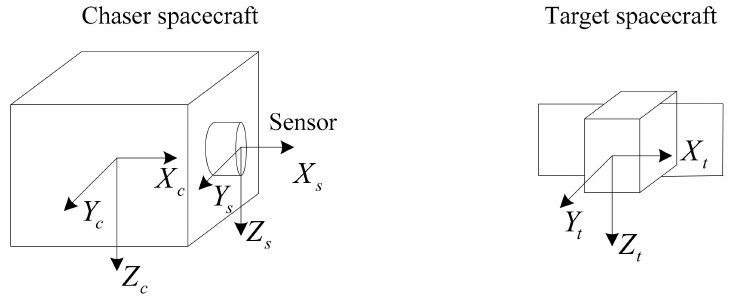
Figure 1. The definition of reference